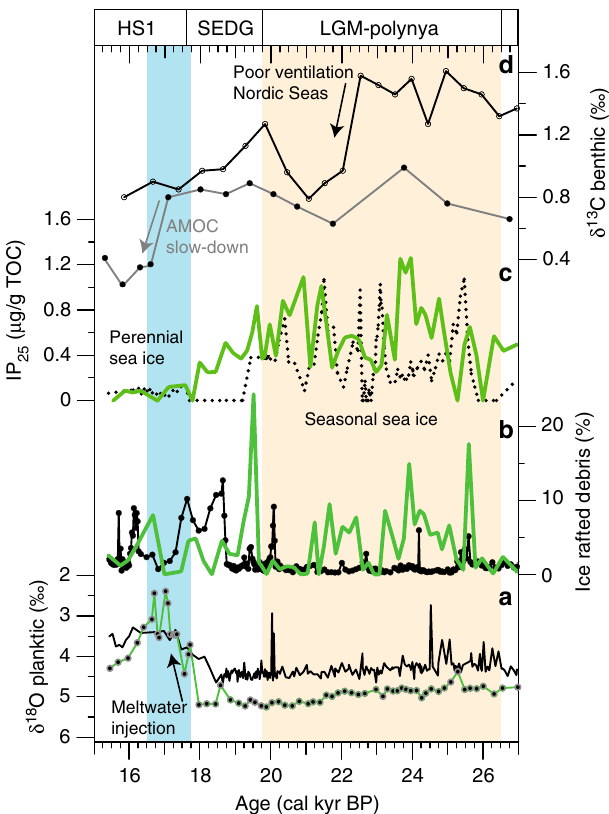
Fig. 6 Sea ice and ice sheet dynamics along the western/northern Barents Sea margin during the LGM. a Planktic δ 18 O (in ‰ ) and b ice-rafted debris (%>250 µ m) records from the southwestern (this study: green) and northern (PS2138-1: black) Barents Sea margin 52 . c IP 25 in sediments off northwestern Svalbard (MSM05/5-712-2) (dotted line) 44 and southwestern Barents Sea (green line) (this study). d Benthic foraminifera δ 13 C in the Norwegian Sea (PS1243; black) 14 and the North Atlantic (ODP Site 980; gray) 59 . Timing of ventilation changes in Nordic Seas and AMOC slow down is marked by arrows. See references for exact location of these cores. Legend of colored rectangles as in Fig.